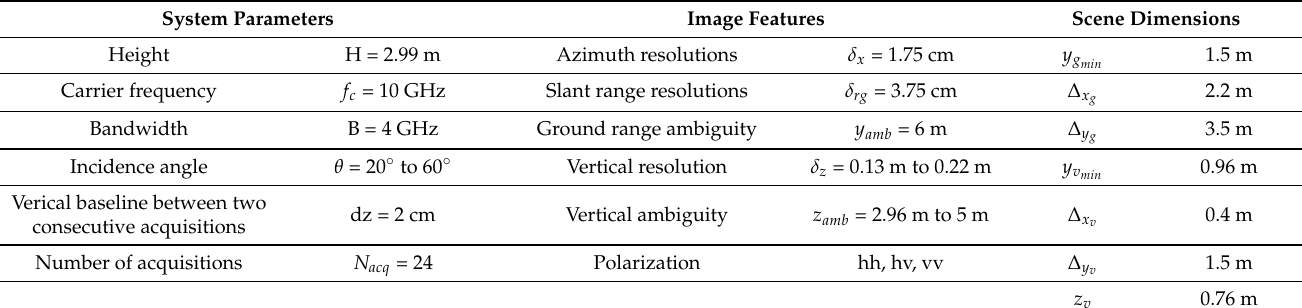
Table 1. System parameters, image features, and scene